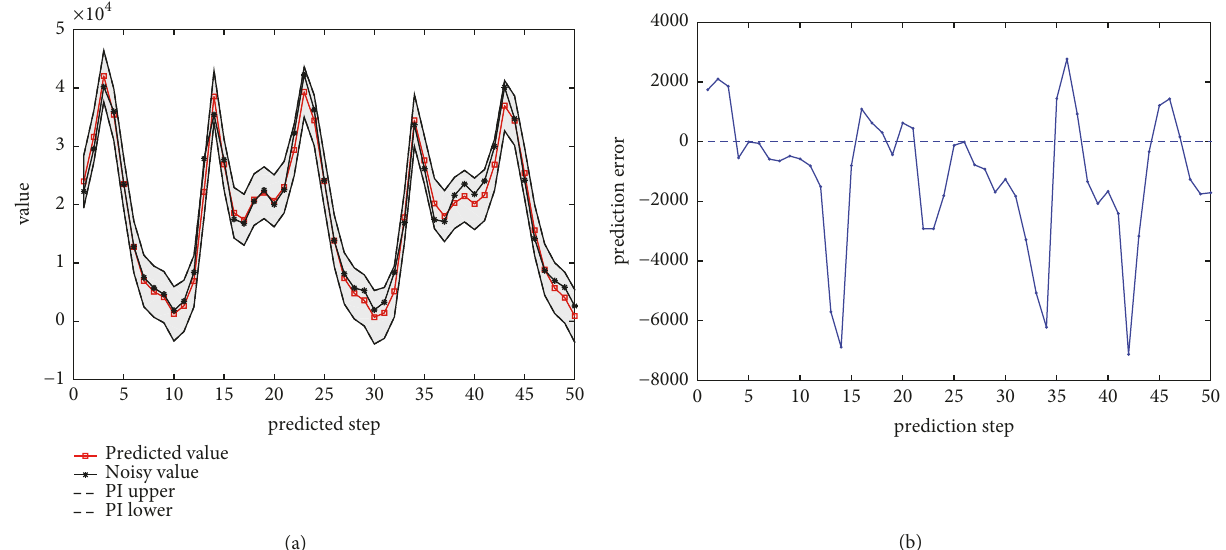
Figure 10: Prediction results for the data of Tournament 1: (a) the constructed PIs; (b) the corresponding prediction error.